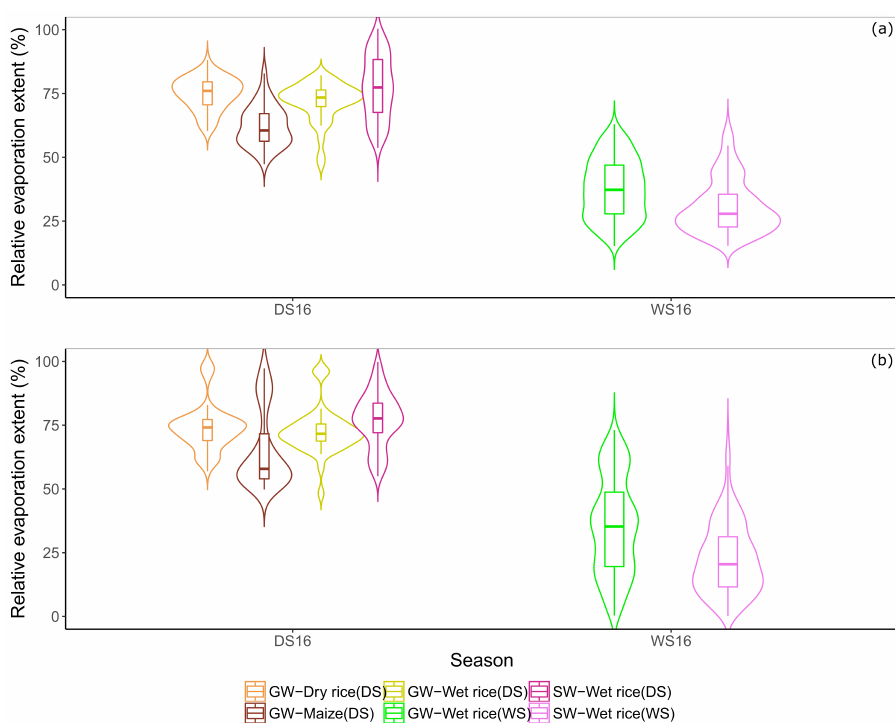
Figure 7. Estimated extent of relative source evaporation (%) of groundwater (GW) and surface water (SW) from different crops (maize, wet rice, and dry rice), using a simple two-point δ 2 H ( a ) and δ 18 O ( b ) based mixing model (Equation (1)) for dry season (DS) and wet season (WS)